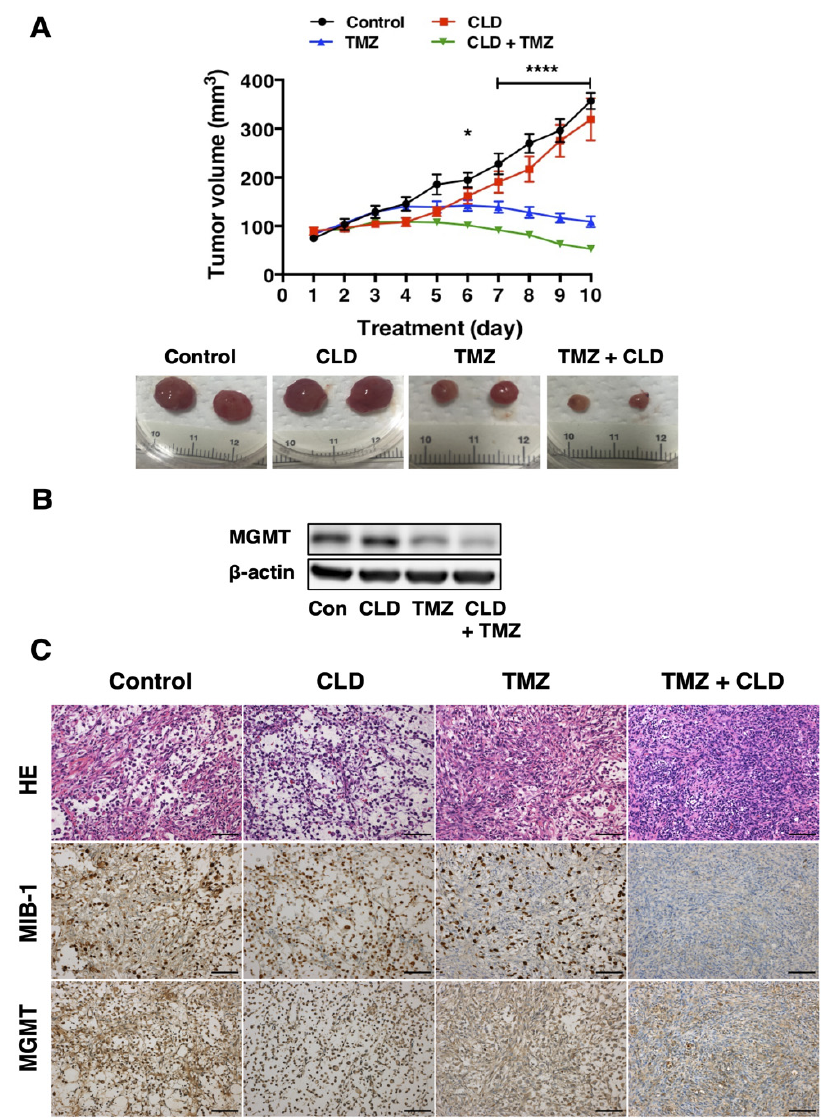
Figure 6. Synergistic effect of the clindamycin and temozolomide combined treatment in a subcutaneous tumor model. Efficacy of combined treatment for NGT41 subcutaneous xenograft model. Data represent the relationship between treatment days and tumor volume ( A ). Mice were administered a vehicle control, CLD (400 mg/kg), TMZ (5 mg/kg), or CLD (400 mg/kg) in combination with TMZ (5 mg/kg) for 10 days. Data are shown as means ± SE ( N = 7). The p -values represent statistical comparisons between the CLD alone and combined treatment groups using Bonferroni multiple comparisons between independent samples (* p = 0.0299 and **** p < 0.0001 vs. CLD alone: two-way ANOVA). Subcutaneous tumors were resected on day 10 and then homogenized. The lysates were subjected to Western blot analysis using an anti-MGMT antibody ( B ). The subcutaneous tumor resected from the NGT41 xenograft and its histological images are shown ( C ). Representative micrographs of subcutaneous tumors using HE and immunohistochemical staining with anti-MIB-1 and anti-MGMT antibodies on day 10. The results shown are representative of four independent experiments. Scale bar: 100 µ